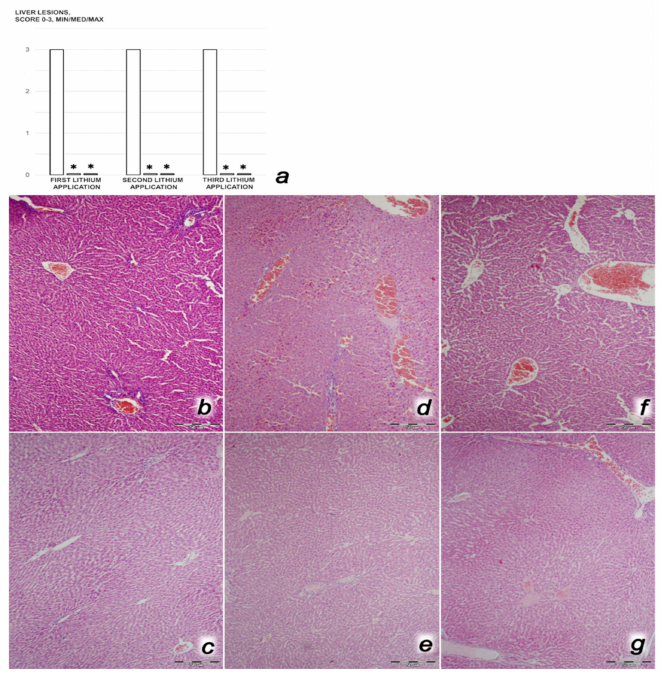
Figure 6. Liver pathology. ( a ) Microscopy scoring of the lesions of the liver (scored 0–3) Min/Med/Max, ( a ) in the rats treated with lithium sulphate (500 mg/kg/day intraperitoneally for 3 days) that received medication (BPC 157 10 µ g/kg (light gray bars), 10 ng/kg (dark gray bars); saline 5 mL/kg (white bars)) given intraperitoneally. Six rats/group/interval. * p < 0.05, at least, vs. control. ( b – g ) Illustrative histology presentation of the affected liver ( b , d , f , control), and liver lesions counteraction ( c , e , g , BPC 157); first lithium application ( b , control; c , BPC 157), second lithium application ( d , control; e , BPC 157), third lithium application ( f , control; g , BPC 157). A congestion and dilatation of central veins, sinusoids and portal tracts vessels was found in